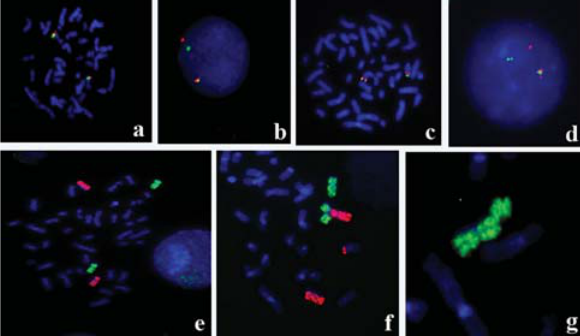
Figure 3 - FISH analysis of peripheral lymphocytes treated with etopo- side. a) and b) Normal methaphase with two MLL copies at 11q23